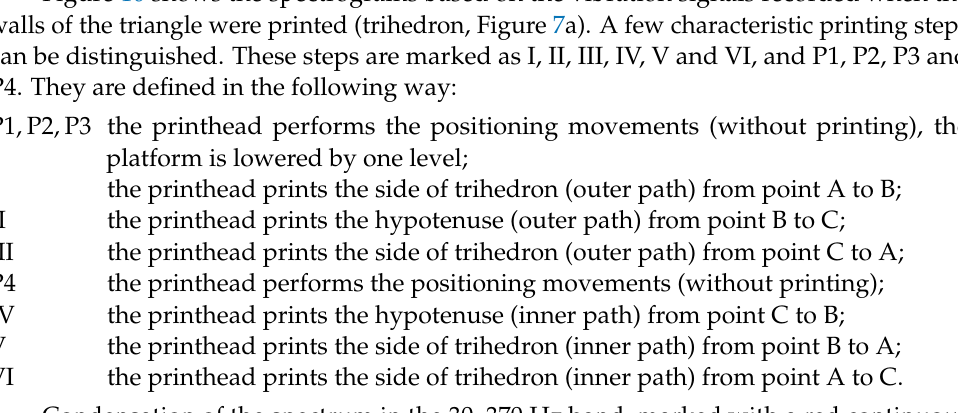
Figure 10. The spectrograms of printer vibrations when the trihedron object was printed. Condensation of the spectrum in the 30–370 Hz band, marked with a red continuous line in spectrograms, informs about the movement of the platform and/or head position- ing.